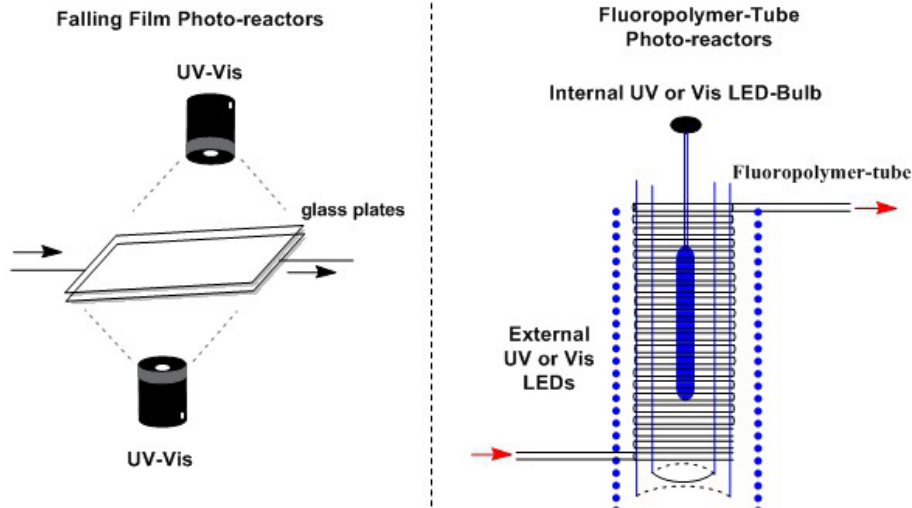
Figure 5 – The two main flow-photoreactor